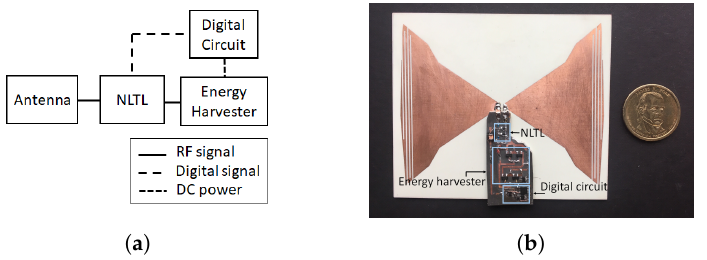
Figure 12. ( a ) Schematic block diagram of the harmonic RFID, and ( b ) implementation of the harmonic RFID circuit as in [64]. [Reproduced with permission from S. Mondal, A continuous-mode single-antenna harmonic RFID tag; published by IEEE,